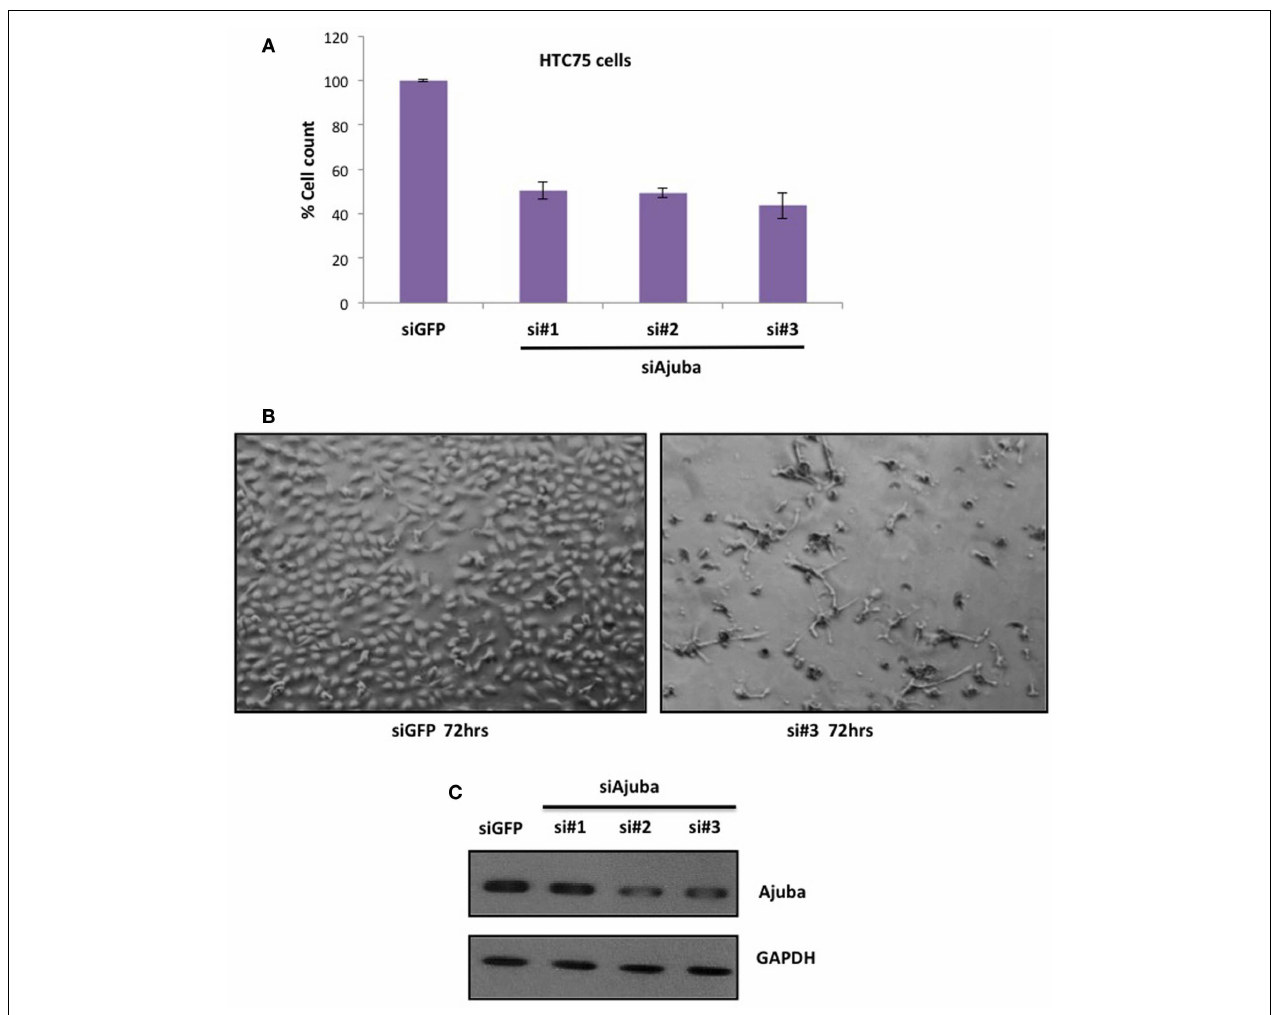
shown 72h after transfection, with GFP siRNA as controls. (C) Western blot showing the depletion of Ajuba by siRNA with three different target